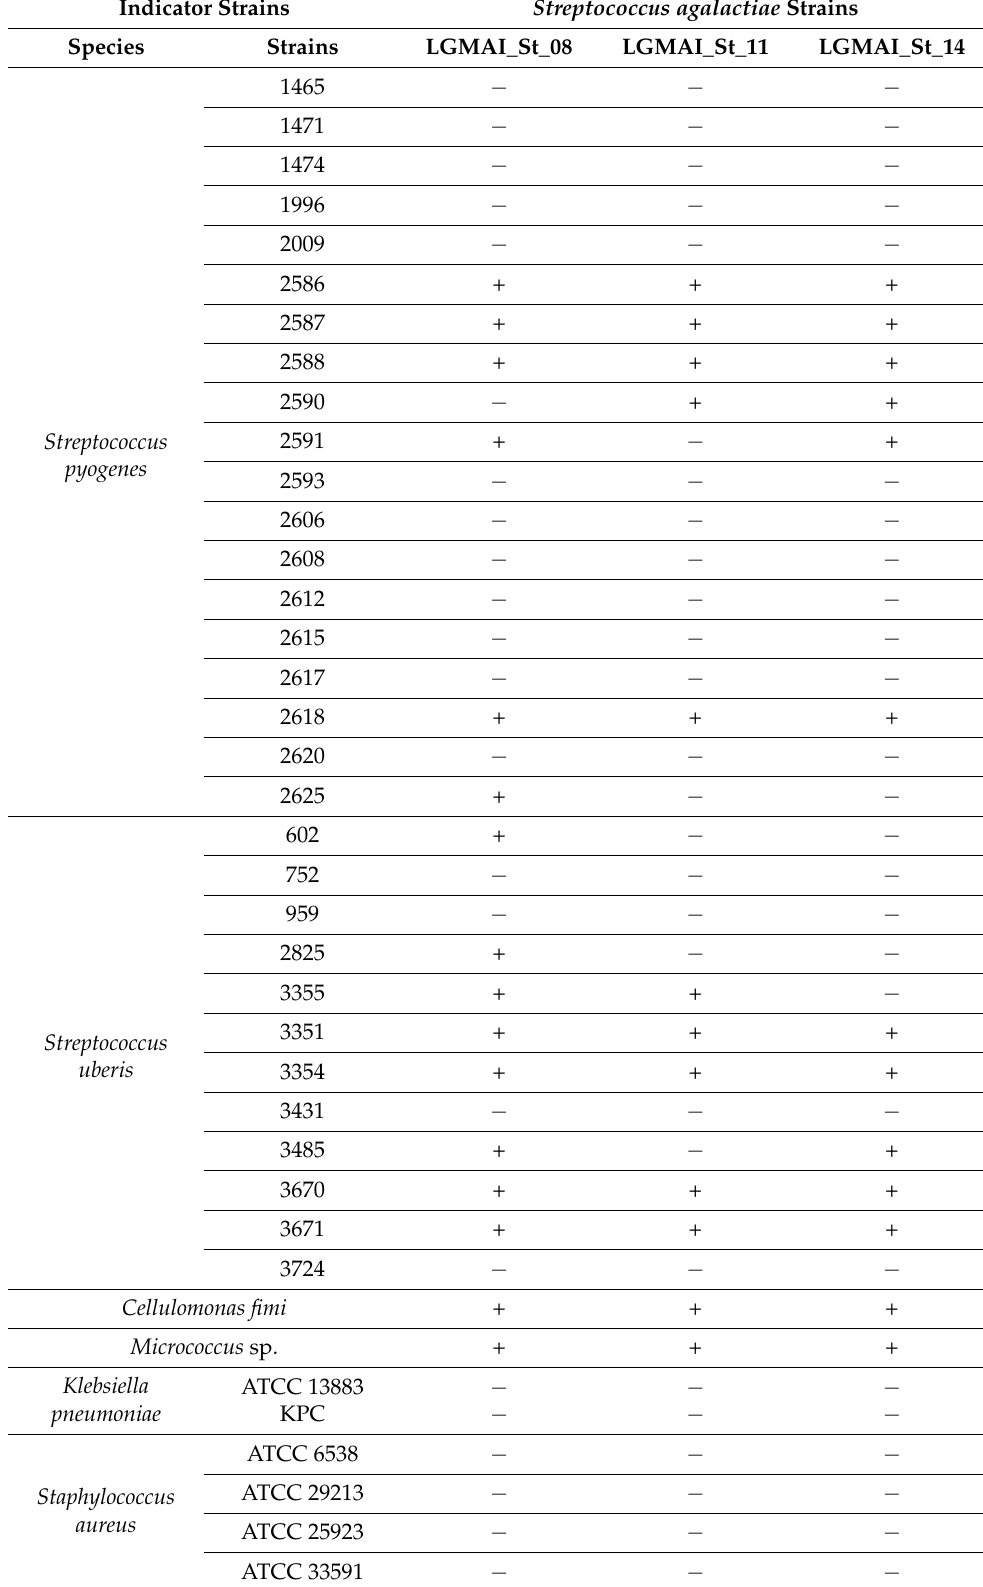
Table 6. Cont. Indicator